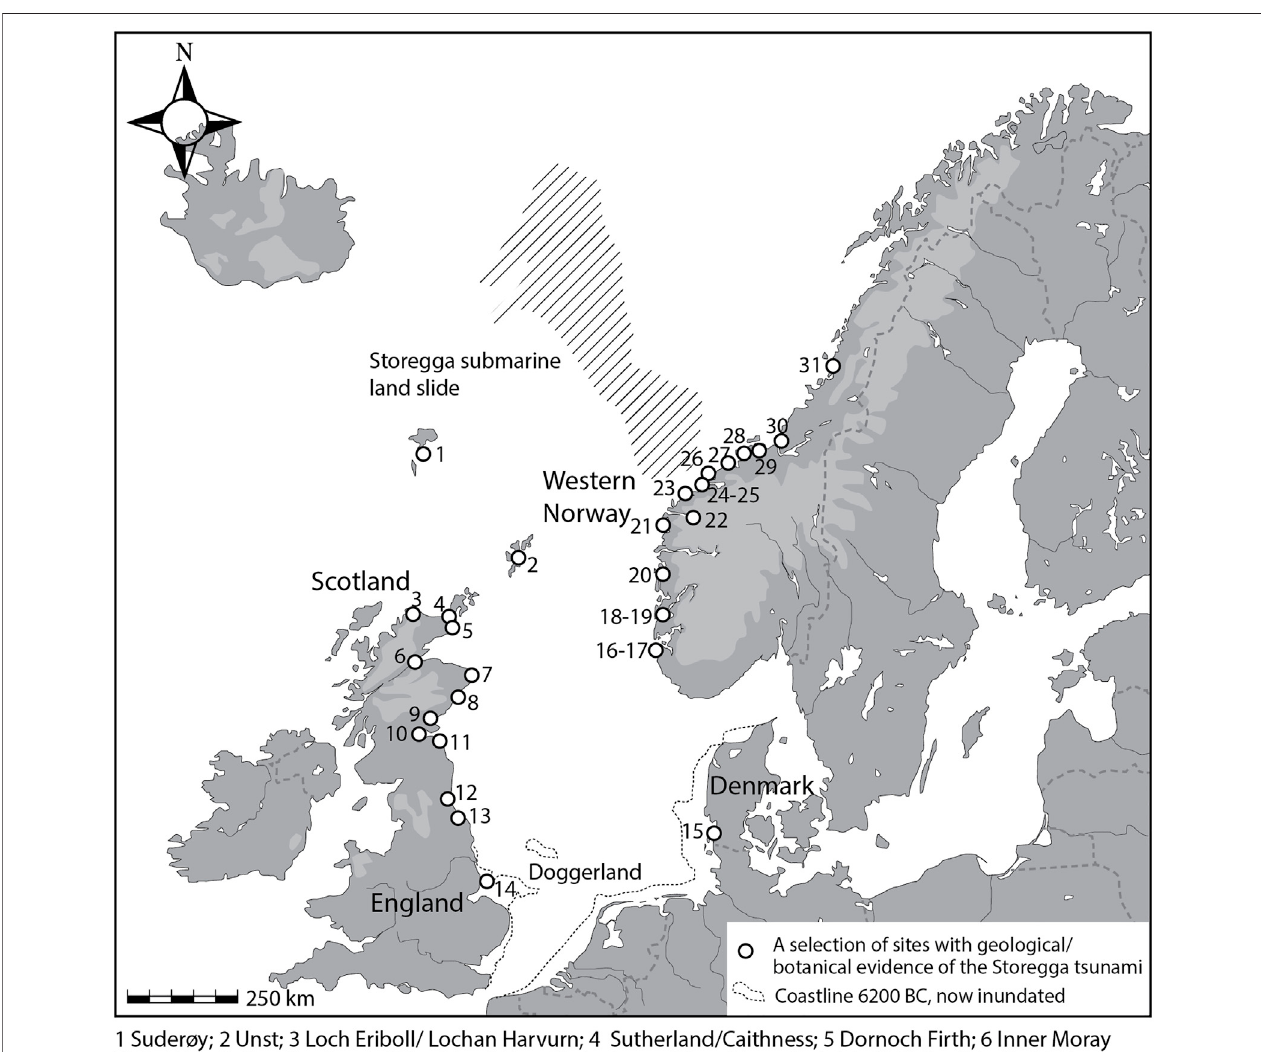
FIGURE 2 | Map with sites where Storegga tsunami deposits have been geologically and botanically identi fi ed. Information is compiled from published papers, book chapters and reports, as well as unpublished (archival) excavation reports].